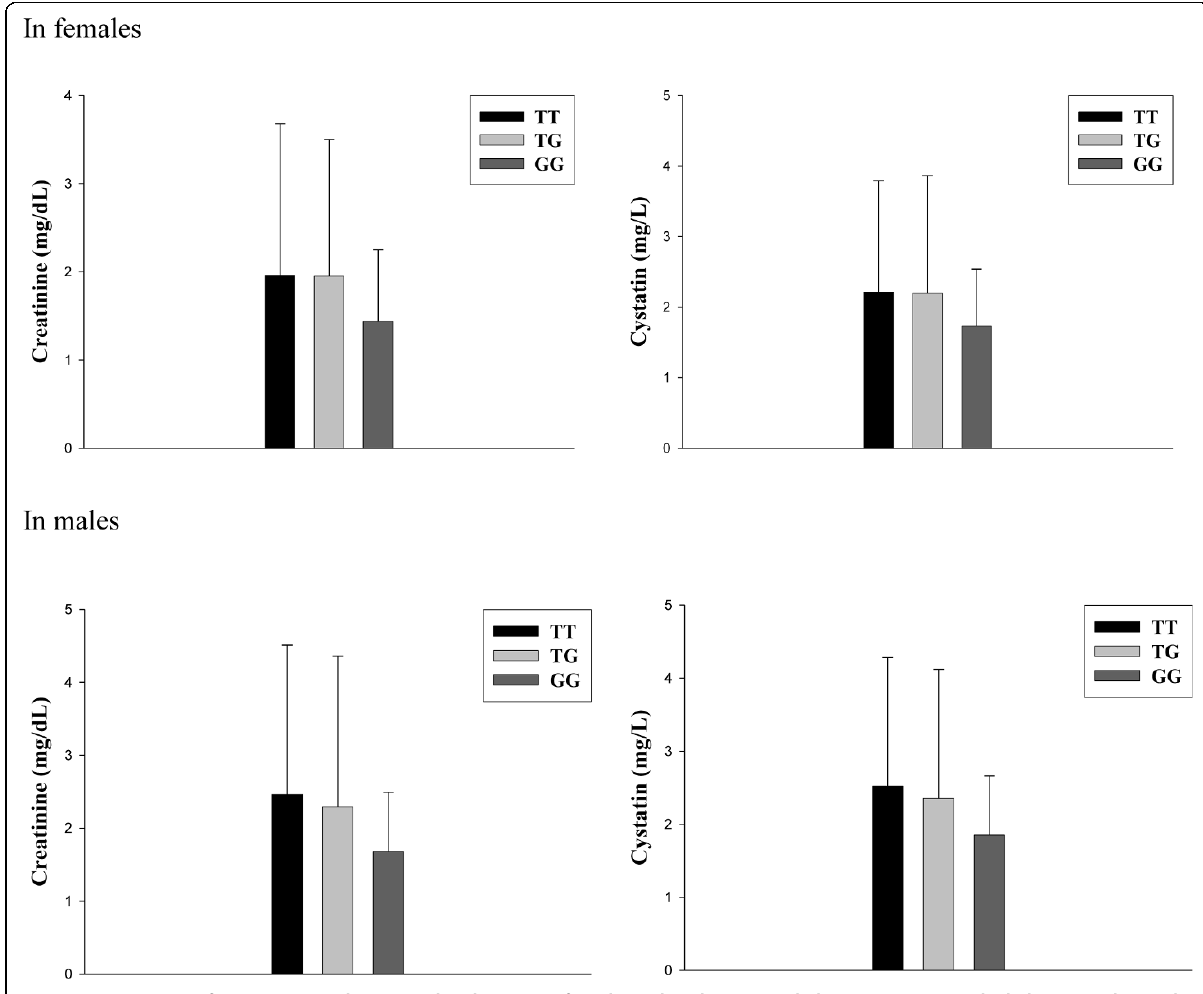
Figure 1 Variation of creatinine and cystatin levels among female and male type 1 diabetes patients with diabetic nephropathy according to the genotypes of Leu359Ile variant in the MCF2L2 gene . Untransformed mean values (± SD) for creatinine and cystatin levels in female and male type 1 diabetes patients with DN are shown. The patients with DN carrying GG genotype had tendency decreased levels of creatinine and cystatin compared the carriers with TT and TG genotypes. But, the differences were not statistically significant mainly due to the higher standard deviations.